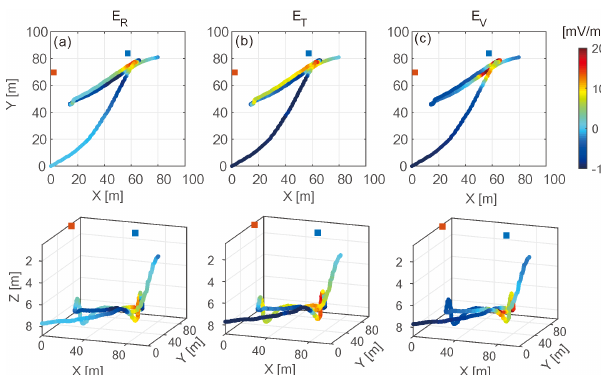
Figure 3. The planar distribution of the three components of the electrical field measured by the AUV-based SP system (planar view in the upper panels, 3D view in the lower panels): (a) inline com- ponent of the electrical field, (b) crossline component of the elec- trical field, (c) vertical component of the electrical field. Red and blue dots represent the positive and negative poles of the artificial source, respectively.